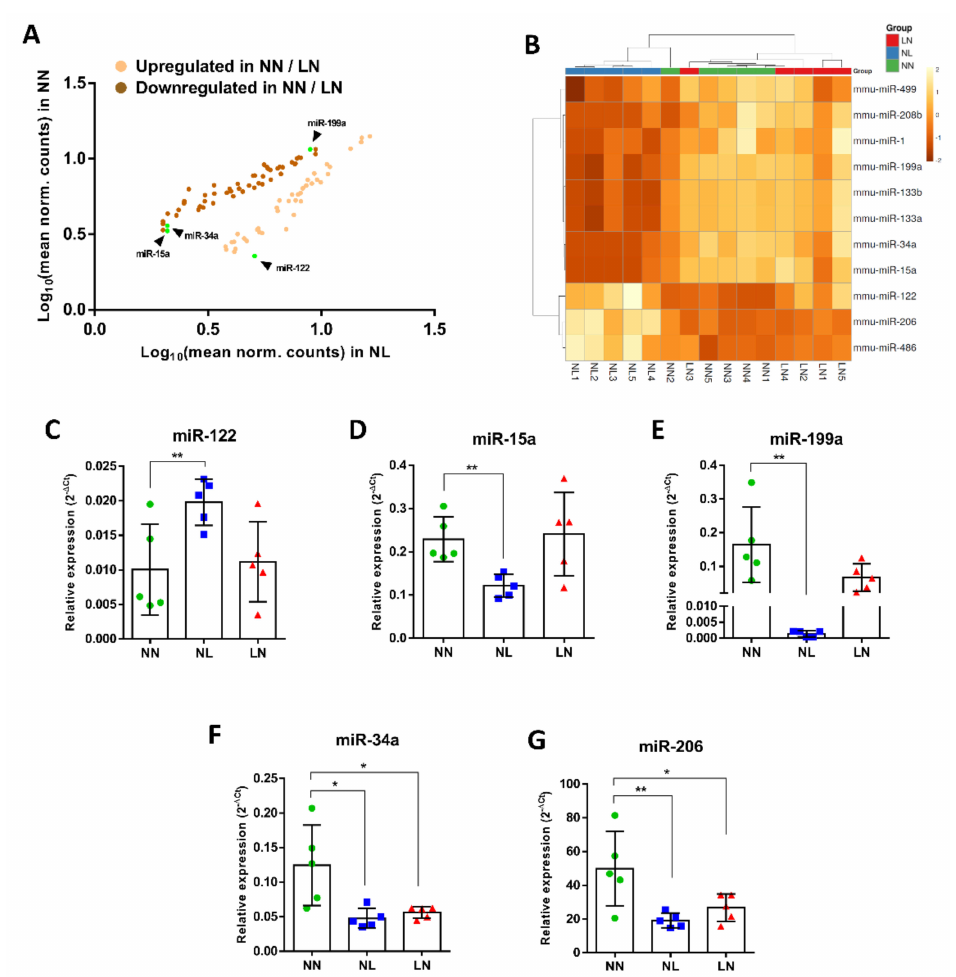
Figure 4. Validation of selected differentially expressed miRs by qPCR. Among the 92 miRs with DE between NN/LN and NL as determined by small RNA-seq, miR-122 expression was higher in NL, whereas miR-15a, -34a and -199a were found upregulated in NN and LN ( A ). The combination of these four miRs with known myomiRs revealed an interactive set of skeletal muscle-associated miRs in which the degree of DE between NN/LN and NL is very strong, as illustrated by the expression heatmap ( B ). The colour of each entry is determined by the number of reads, ranging from yellow (negative values) to brown (positive values). To confirm the expression levels, validation by qPCR showed increased expression in NL, but not in LN, for miR-122 ( C ). The results were similar between small RNA-seq and qPCR for miR-15a ( D ) and miR-199a ( E ), while for miR-34a ( F ) and miR-206 ( G ) were different between the two detection systems. * p < 0.05, ** p <